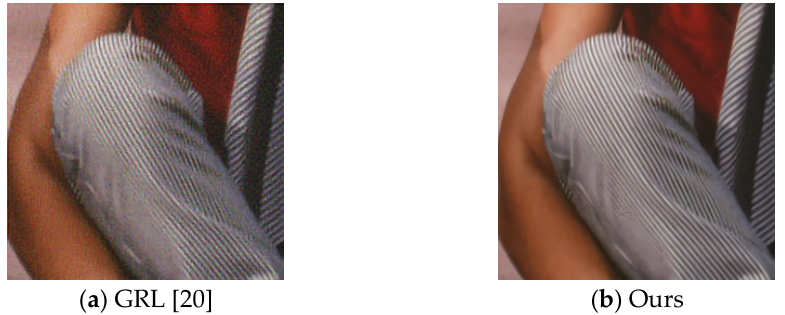
Figure 8. Comparison with lines restoration between GRL and Ours.